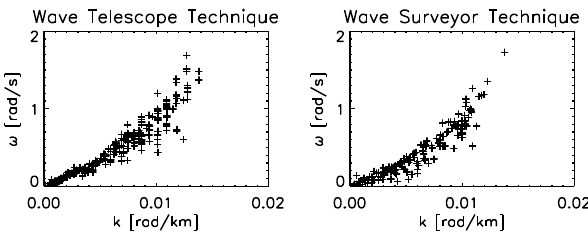
Fig. 8. Dispersion relation of foreshock waves measured by Cluster. Left panel displays the dispersion relation determined by the wave telescope technique (Narita et al., 2007), and right panel displays that determined by the wave surveyor technique (Vogt et al., 2008). Wave numbers are in the direction to the mean magnetic field and frequencies are given in the flow rest frame after the Dopper correc-